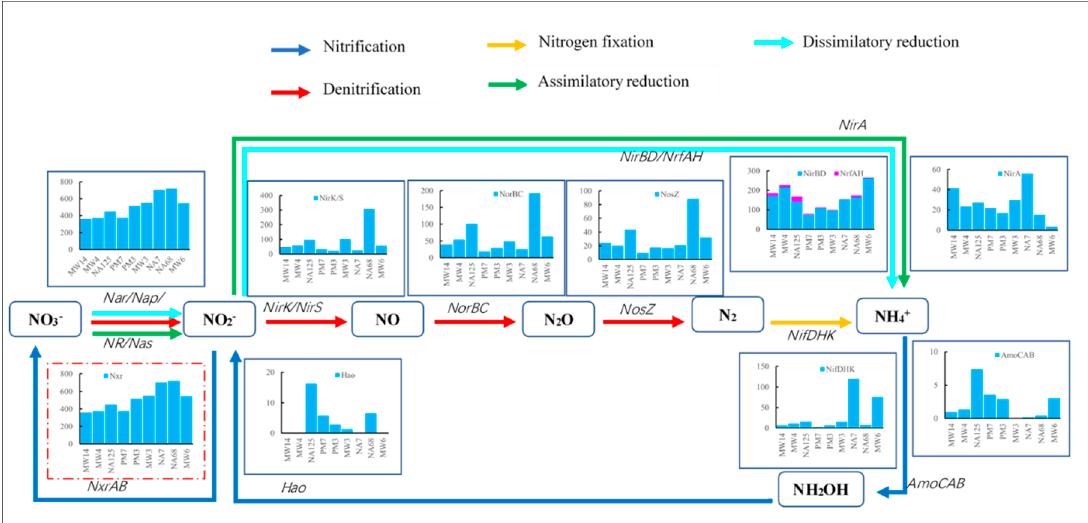
Figure 3. Gene abundance of methane metabolic pathways in the aquifer.